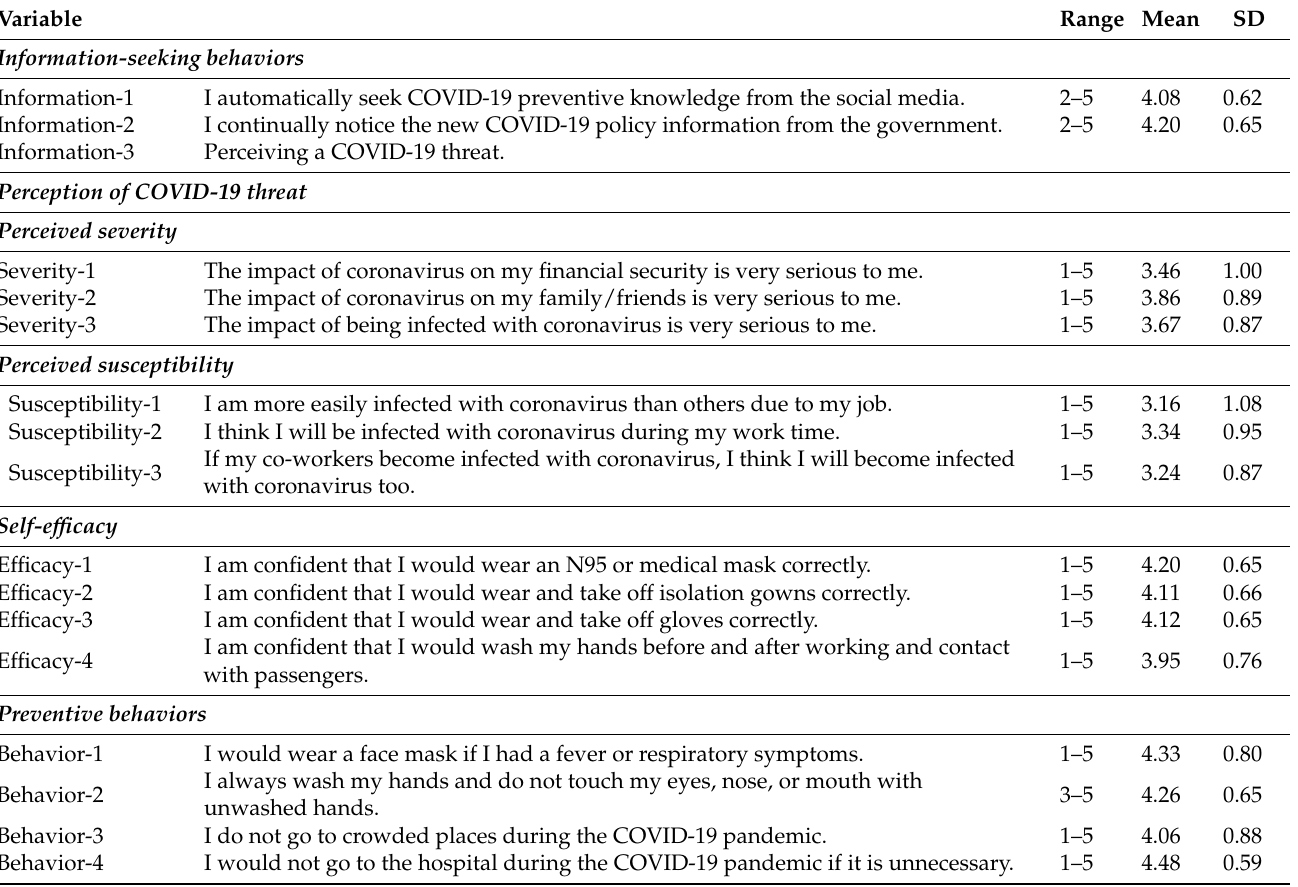
Table 2. Descriptive statistics for the information-seeking behavior, perceived severity,